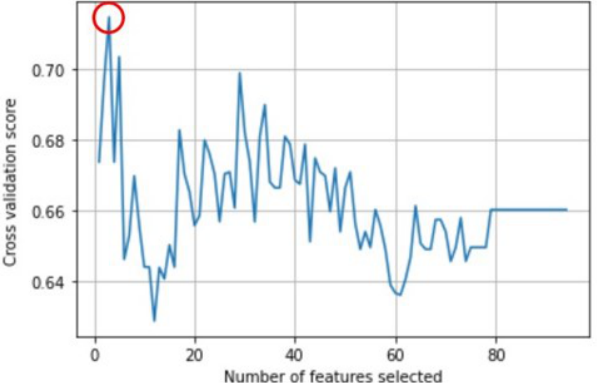
Figure 8. Recursive feature elimination performance with XGBoost.